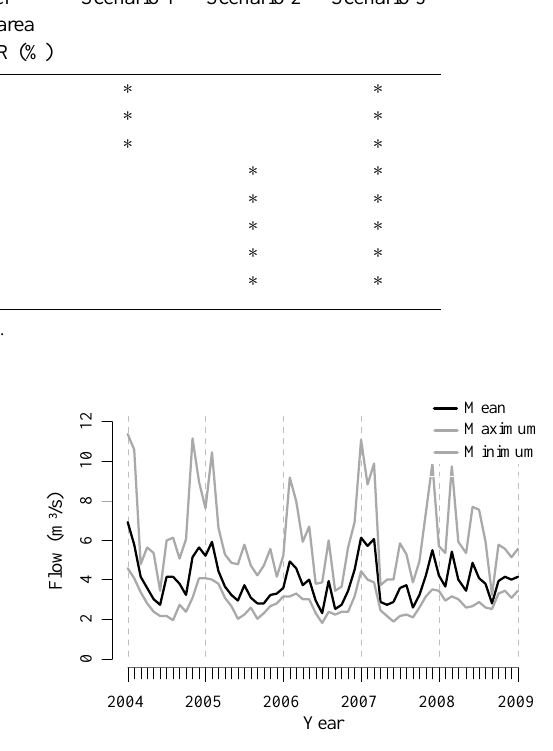
Fig. 5. Monthly mean, minimum and maximum of the daily mea- sured flow (m 3 s − 1 ) for the period 2004–2008 at the outlet station (Varendonk) of the Grote Nete